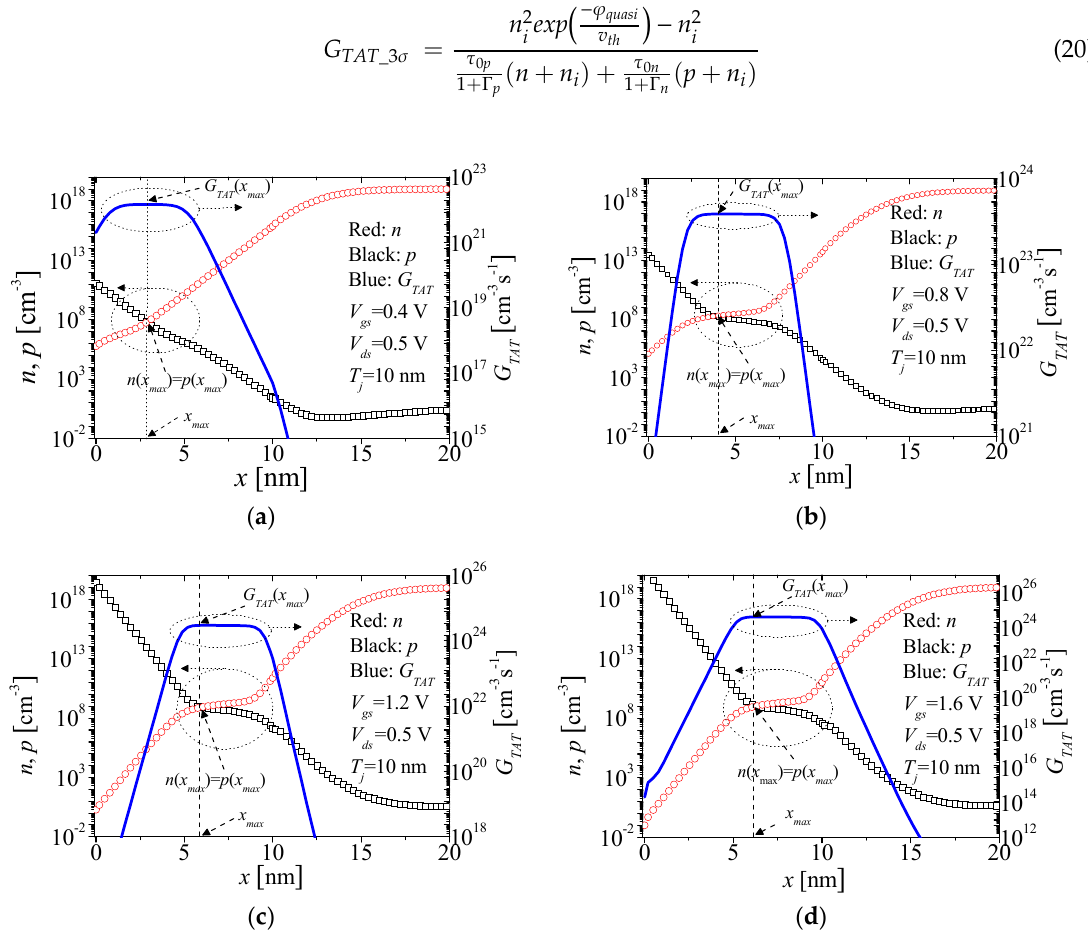
Figure 3. ( a – d ) n , p (left-axis), and G TAT (right-axis) at V gs = 0.4, 0.8, 1.2, and 1.6 V, respectively, all at V ds = 0.5 V. The location where n = p , and of G TAT_Max , that is at x = x max are identified by arrows.